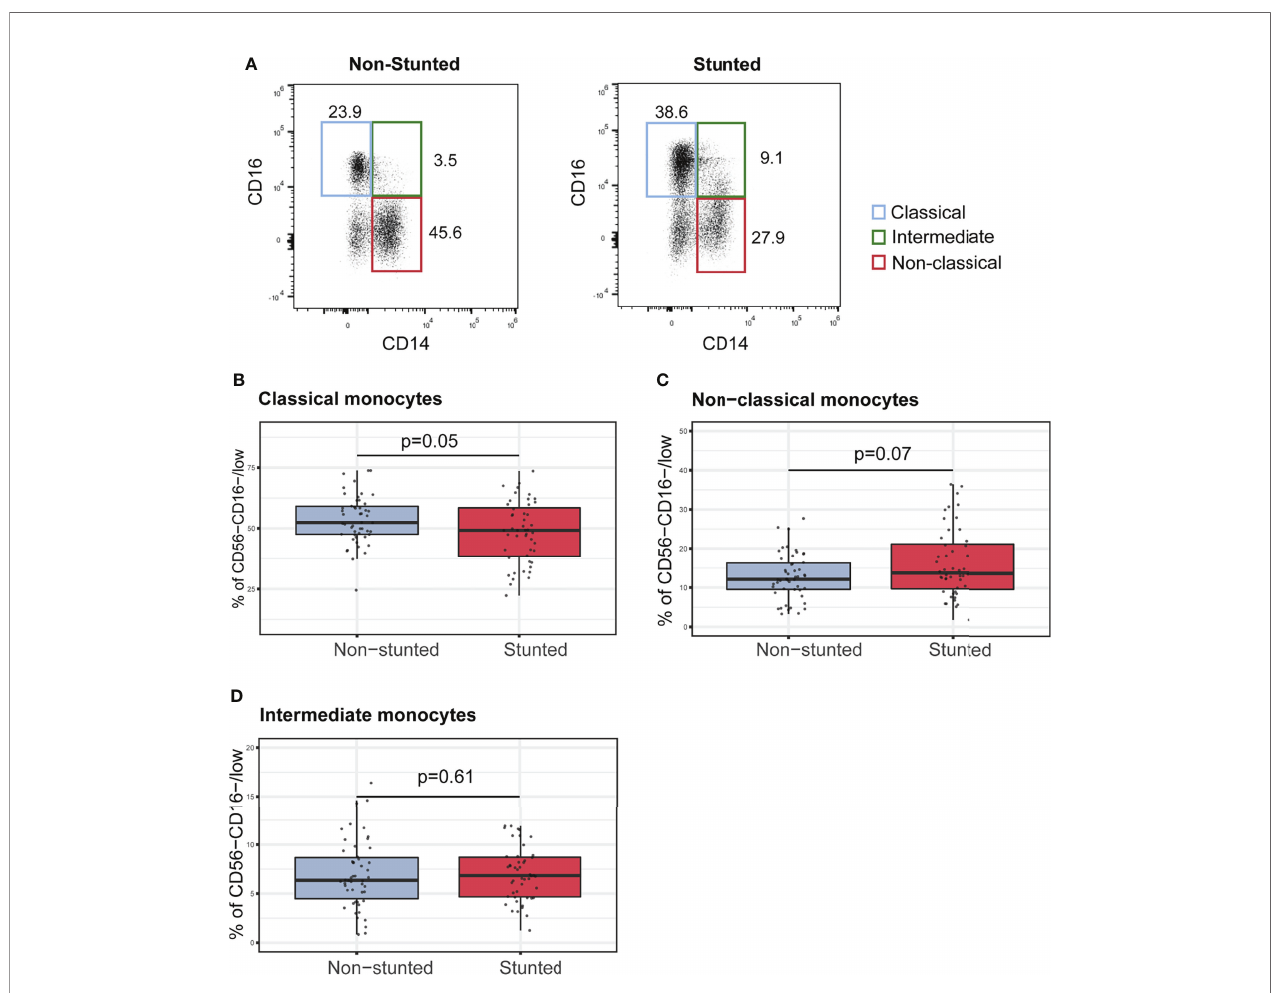
FIGURE 1 | Characterization of monocyte subsets in non-stunted vs. stunted children. (A) Representative fl ow cytometry dot plots of CD14 and CD16 expression on monocyte subsets from non-stunted (left) and stunted (right) children. Classical, non-classical and intermediate monocyte subsets were de fi ned as CD14 + CD16 low/int , CD16 hi CD14 low, and CD16 hi CD14 +, respectively. (B – D) Relationships between stunting status and the percentages of classical, non-classical, and intermediate monocyte populations. NS, non-stunted; S, stunted. Signi fi cance (p<0.05) was determined by Benjamini-Hochberg correction after Mann-Whitney test. N total = 98, N non-stunted = 50, N